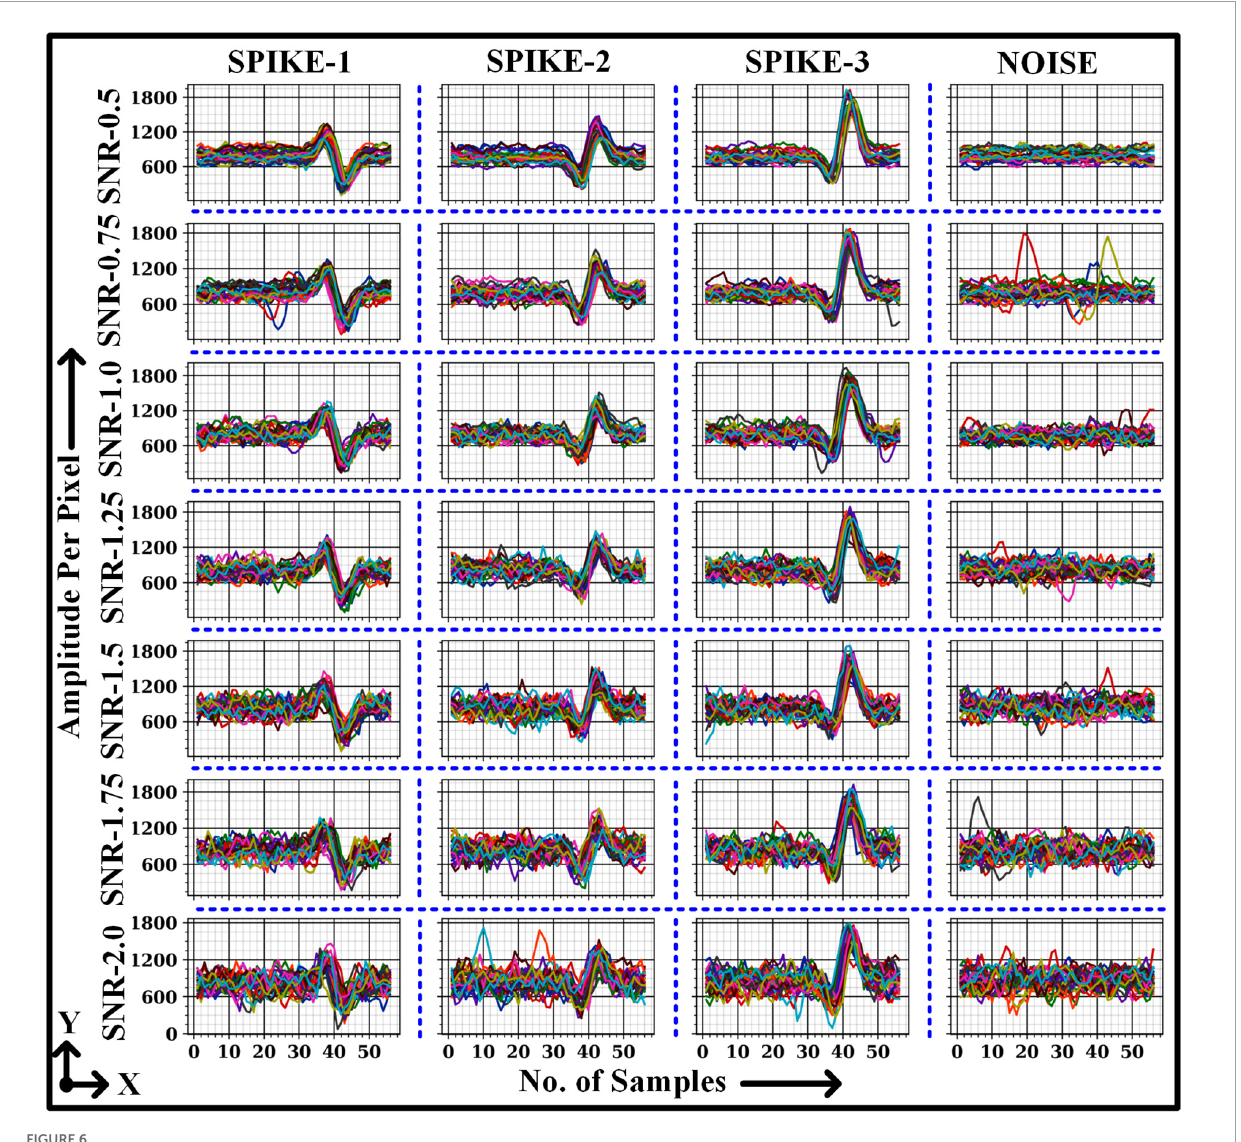
FIGURE6 2D CNN model predicted output on test dataset for various images with SNR